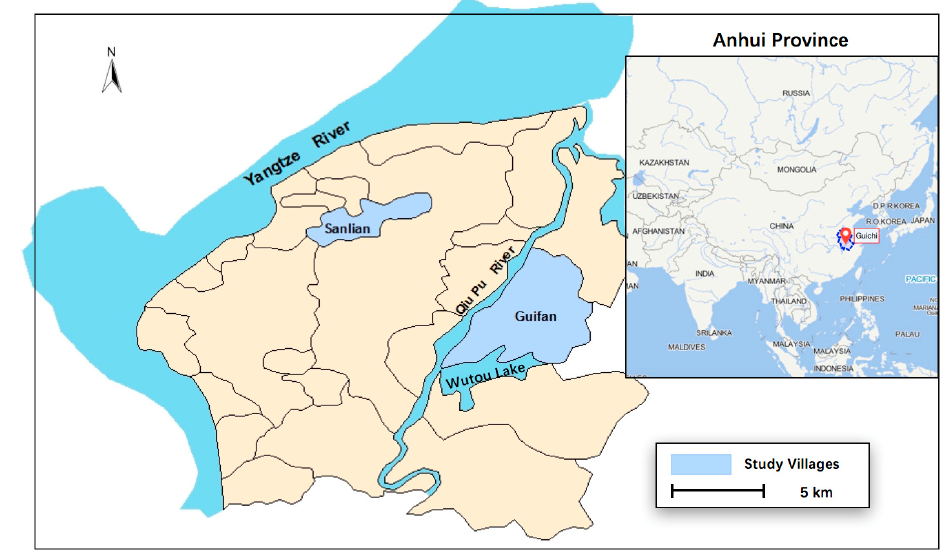
Figure 1. Location of the study area in Guichi district, Anhui Province, China.